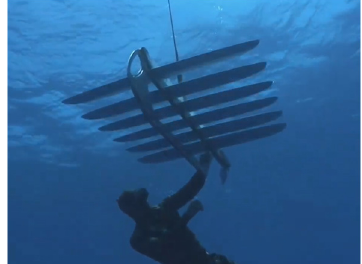
Figure 2. Swimming with the wave glider.